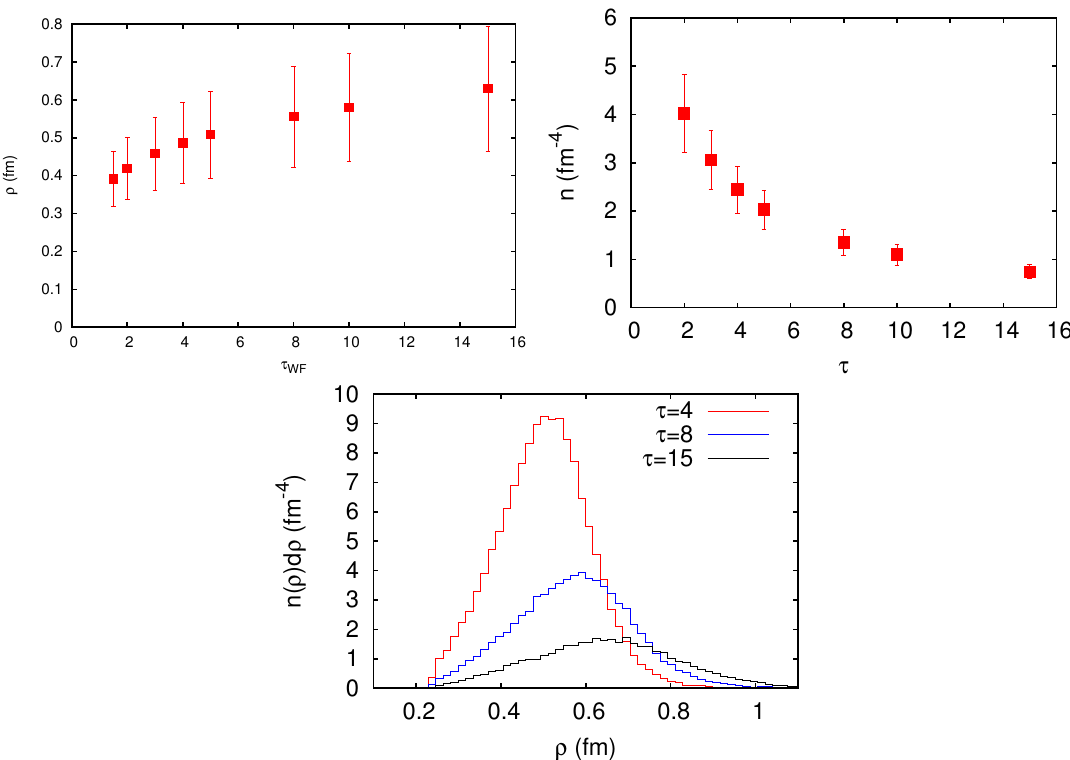
Figure 2 . (Color online) Evolution of the average instanton size (leftmost upper), density (right- most upper) and the histogram of sizes (lower) with the Gradient (cid:13)ow time for 100 quenched gauge (cid:12)eld con(cid:12)gurations corresponding to (cid:12) = 4 : 2 (see table 2). The error bars for the instanton size show the width of the distribution rather than the standard deviation of the mean. For the density, the error bars incorporate an estimate of the systematic uncertainty associated to the distance (cid:12)lter discussed in the